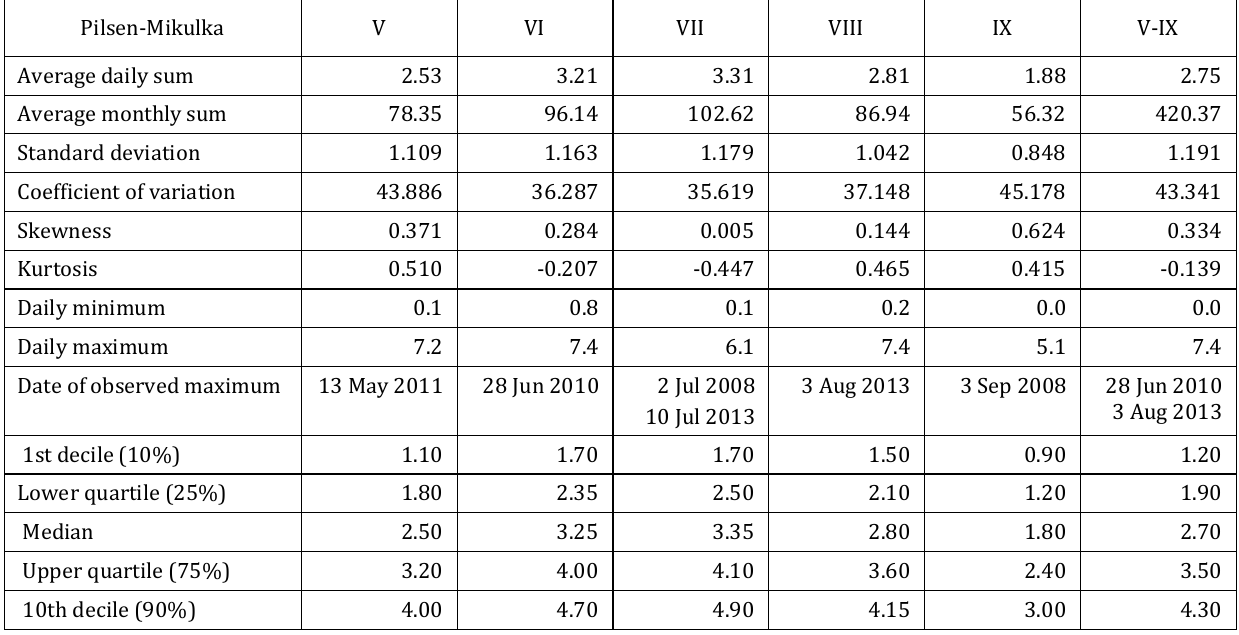
Table 3. Pilsen-Mikulka, Basic statistics of daily evaporation from water surface for the individual months and overall